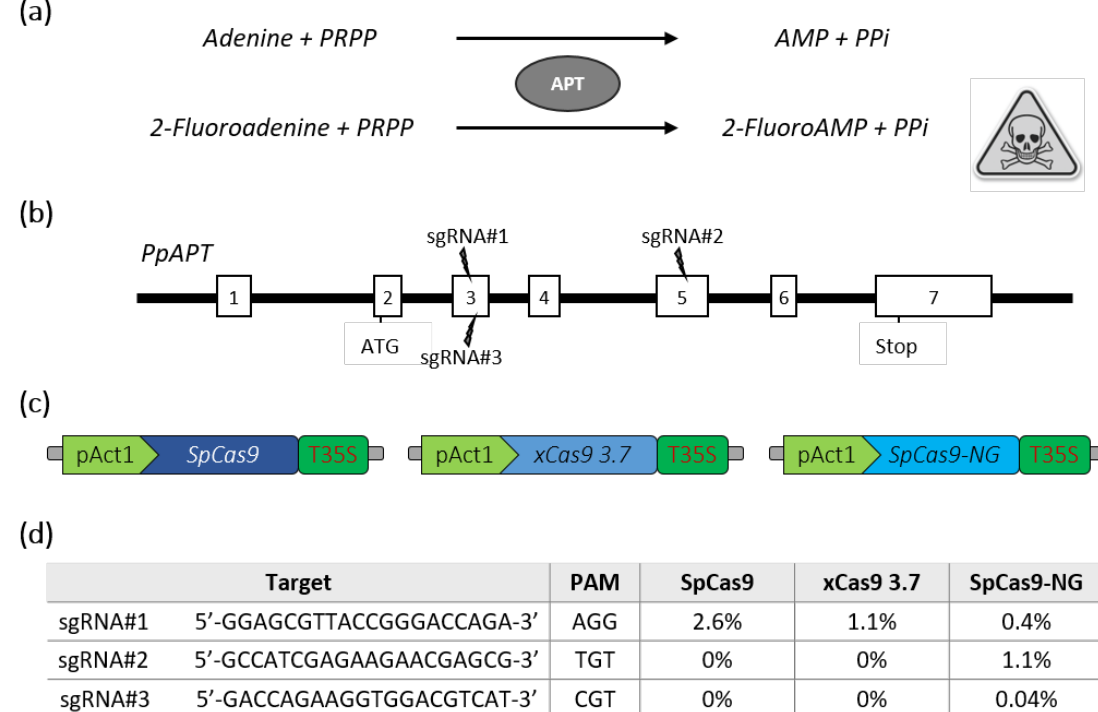
Figure 1. Schematic description of the PpAPT edition strategy and editing efficiencies for SpCas9 variants. ( a ) Adenine phosphoribosyltransferase (APT) catalyses a phosphoribosyl transfer from Phosphoribosyl Pyrophosphate (PRPP) to adenine, forming AMP and releasing pyrophosphate (PPi). In the presence of 2-Fluoroadenine APT will form 2-FluoroAMP, a toxic compound for the cell. ( b ) Structure of the PpAPT gene with the target sites (white rectangles represent exons). ( c ) The three constructs used for PEG-mediated Cas9 expression in P. patens are schematically depicted. ( d ) Results for efficiency of indel mutations using SpCas9, xCas9 3.7 and SpCas9-NG are indicated as the percentage of 2-fluoroadenine resistant protoplasts.